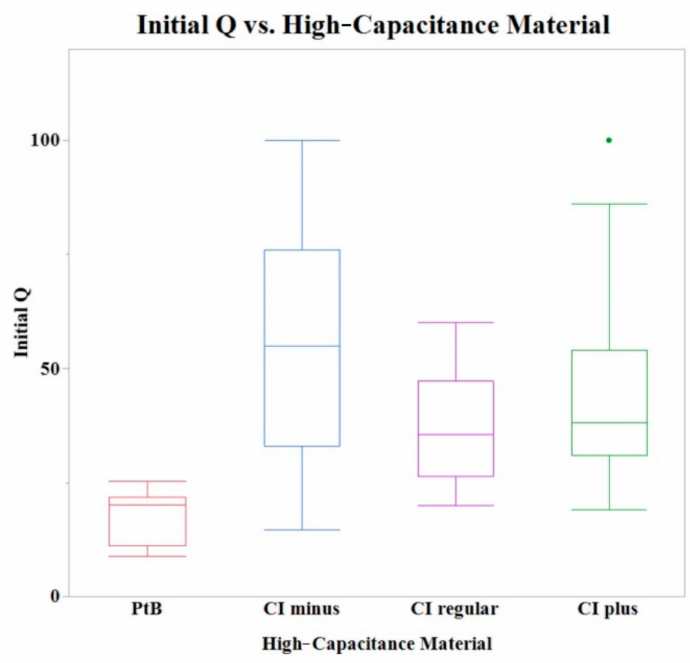
Figure 4. A box plot of the initial Q values for all tested electrodes. A one-way ANOVA found no statistically significant differences between CI binder concentrations (plus, minus, and regular) when PtB electrodes were omitted.